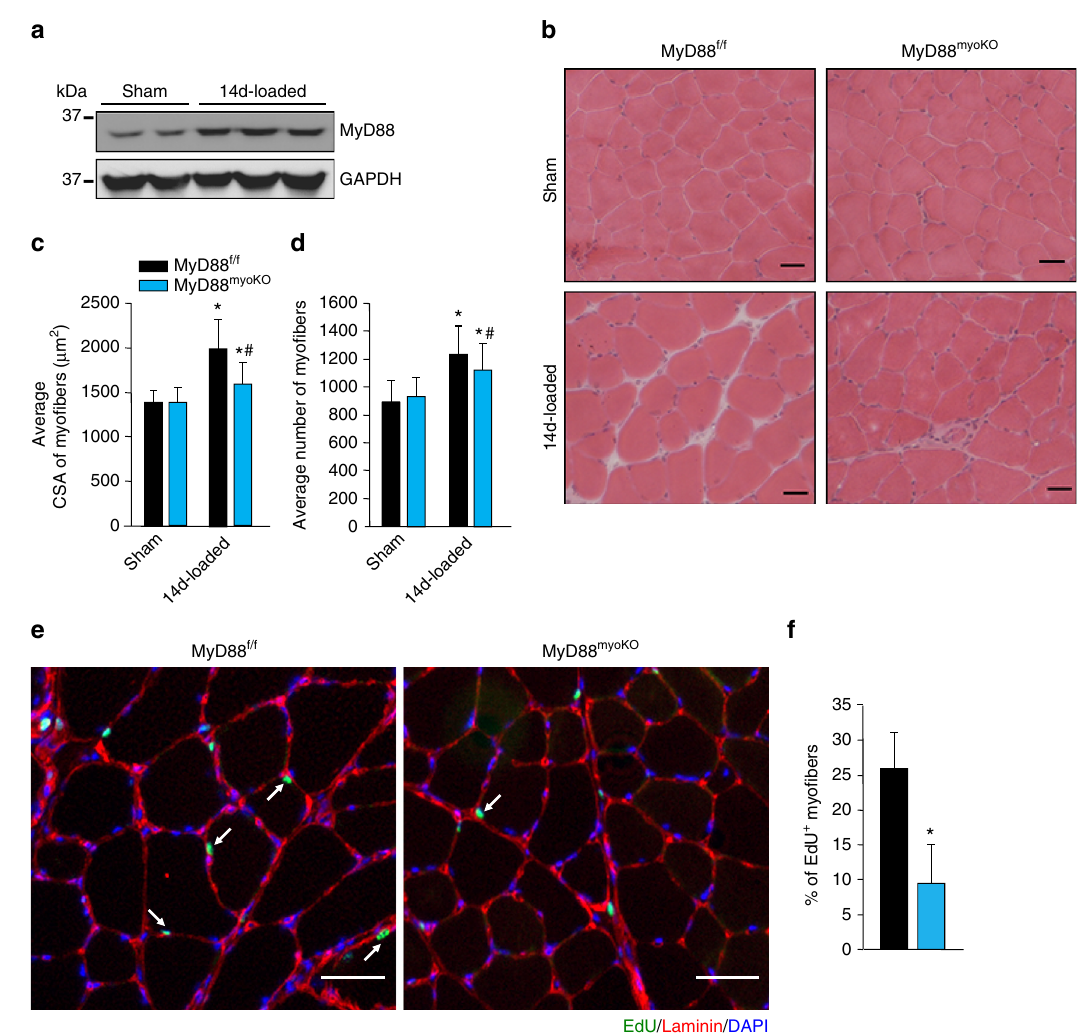
Fig. 8 MyD88 promotes over load-induced myo fi ber hypertrophy in adult mice. a Twelve-week-old WT mice were subjected to sham or synergistic ablation surgery for 14d and the plantaris muscle was analyzed for the protein levels of MyD88 and unrelated protein GAPDH. b Twelve-week-old MyD88 f/f and MyD88 myoKO mice were subjected to sham or synergistic ablation surgery for 14d and the plantaris muscle was isolated and stained with H&E. Representative photomicrographs of H&E-stained plantaris muscle sections are presented here. Scale bar: 50 µ m. c Quanti fi cation of average myo fi ber CSA in the H&E-stained sections of plantaris muscle. d Average number of myo fi bers in plantaris muscle of MyD88 f/f and MyD88 myoKO mice at 14d after synergistic ablation surgery. For c and d , N = 7 mice in each group. In a separate experiment, 12-week-old MyD88 f/f and MyD88 myoKO mice were subjected to sham or synergistic ablation surgery. After 2 days, the mice were given an intraperitoneal injection of EdU, and 12 days later plantaris muscles were collected, and muscle sections prepared were stained to detect EdU, laminin, and nuclei. e Representative photomicrographs after EdU, laminin, and DAPI staining are presented here. Arrows point to intra fi ber EdU + nuclei. Scale bar: 100 µ m. f Quanti fi cation of percentage myo fi bers containing EdU + nuclei in plantaris muscle of MyD88 f/f and MyD88 myoKO mice. N = 4 in each group. Error bars represent s.d. * p < 0.05 from corresponding sham-operated MyD88 f/f or MyD88 myoKO mice by unpaired t -test. # p < 0.05 from 14d-loaded muscle of MyD88 f/f mice by unpaired t